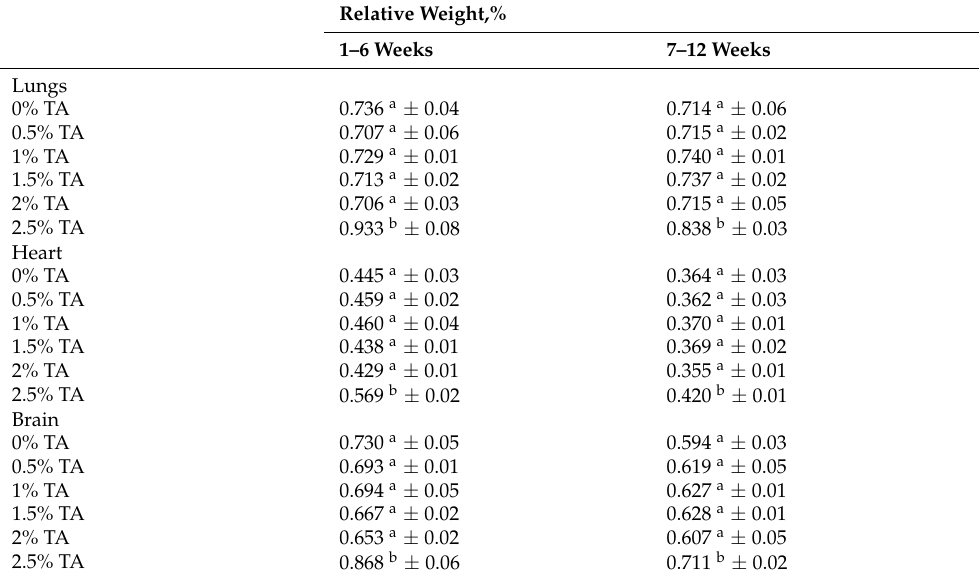
Table 4. Experiment 1—Relative weight of lungs, heart and brain for 6 and 12 weeks of exposure (mean ± SD).